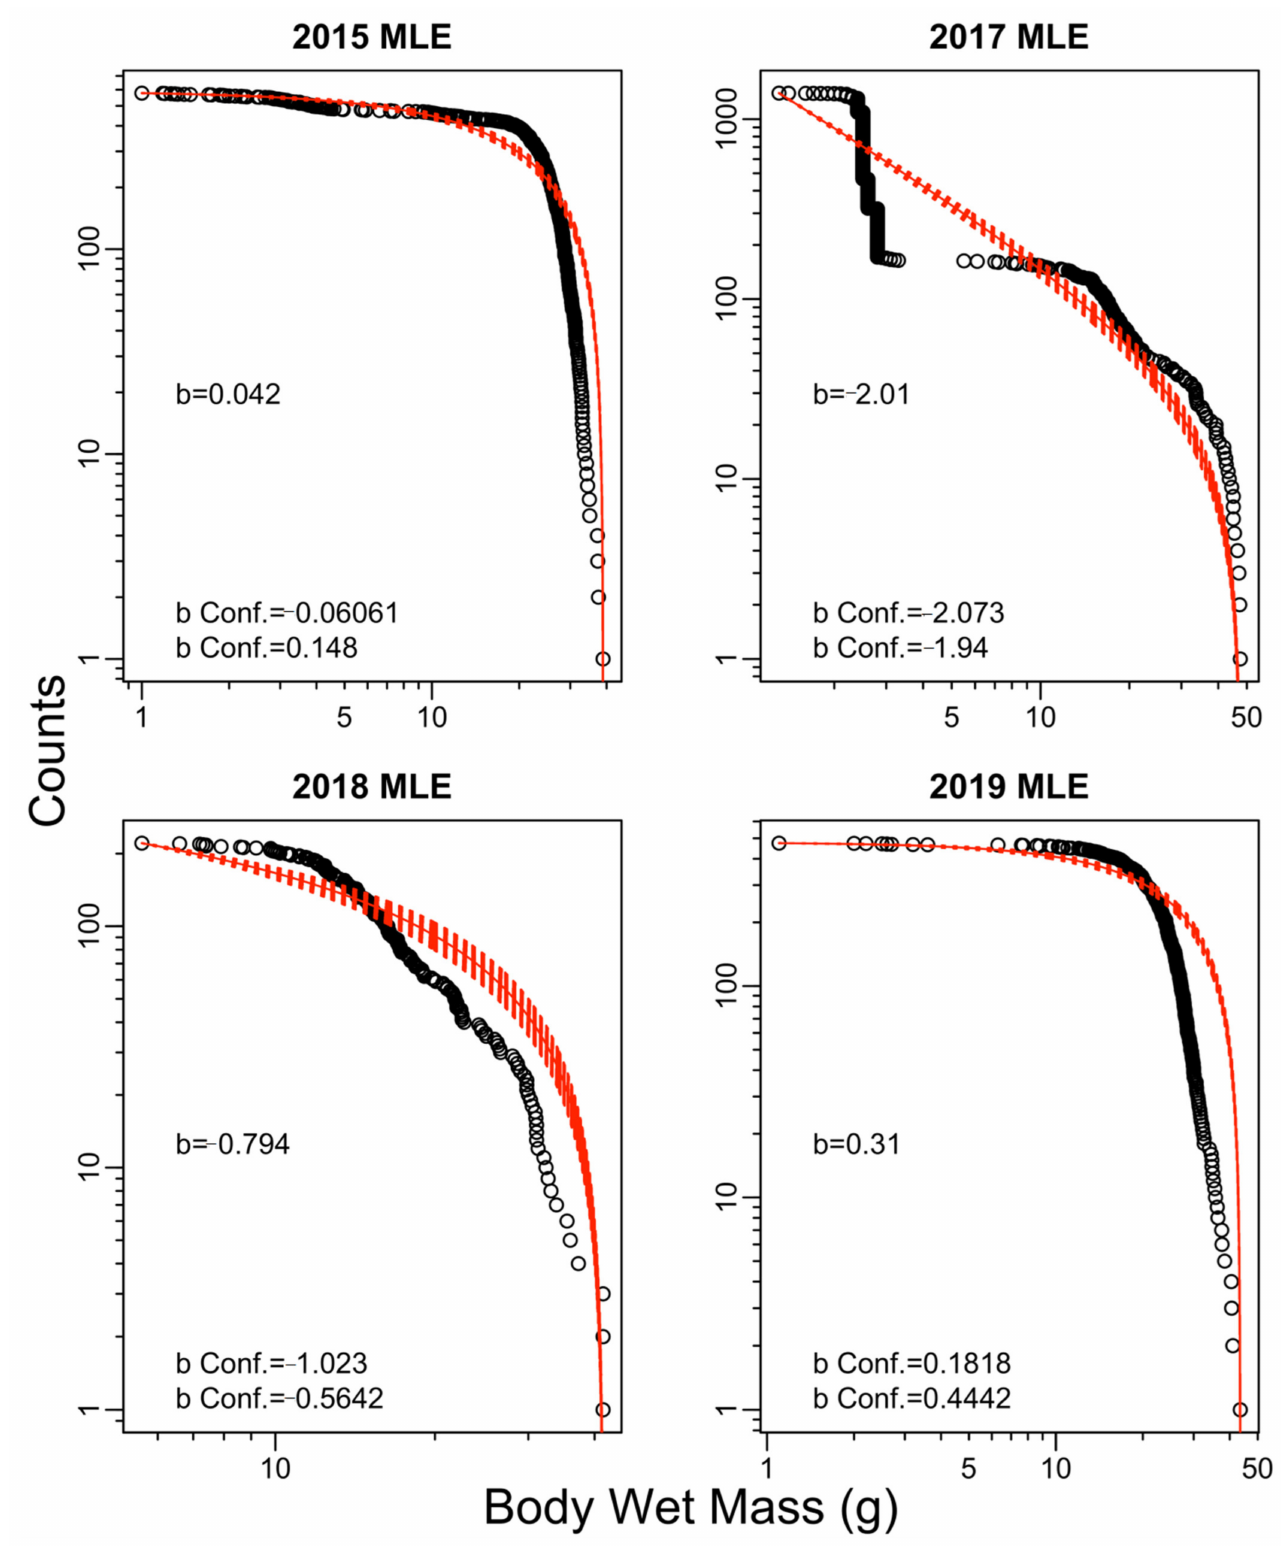
Figure A3. Fish SS with counts and body wet mass (g) fitted using the maximum likelihood estimate of exponent b with the 95% confidence interval of b based on trawling surveys for